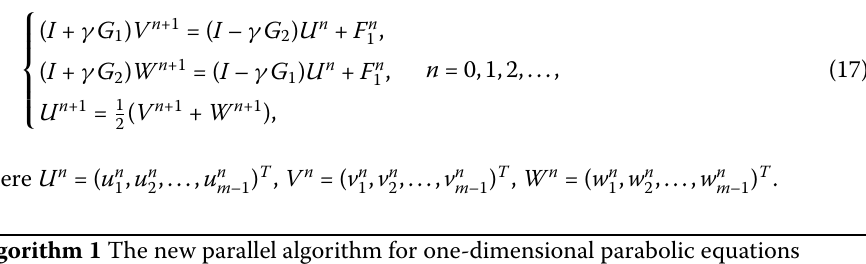
Algorithm 1 The new parallel algorithm for one-dimensional parabolic